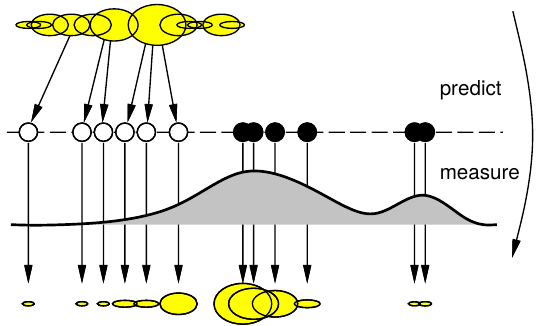
Figure 6. iCONDENSATION Algorithm [32]. Figure6.2:Importancesamplingimprovesthee�ciencyofthesample-setrep- resentation.Themotionmodelhaspredictedthattheobjectwouldremainattheleft,and